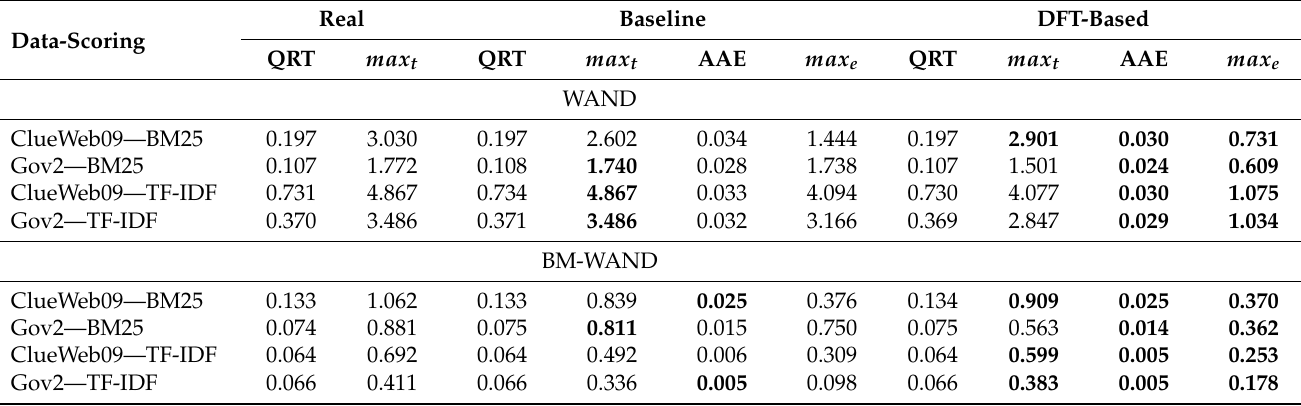
Table 5. Query running time in seconds obtained with the real execution, the baseline and the proposed prediction algorithms. Numbers in bold font indicate better